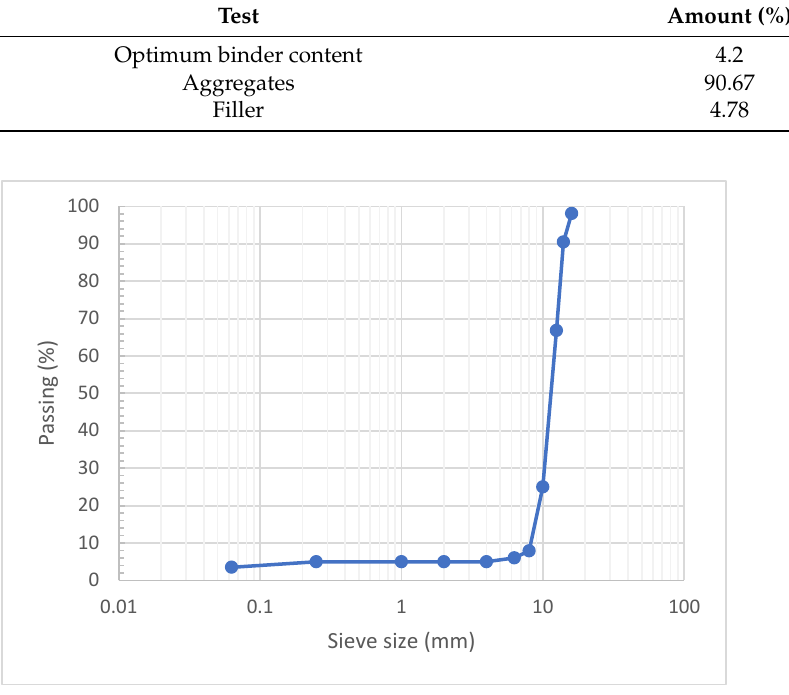
Figure 1. Porous asphalt gradation curve.